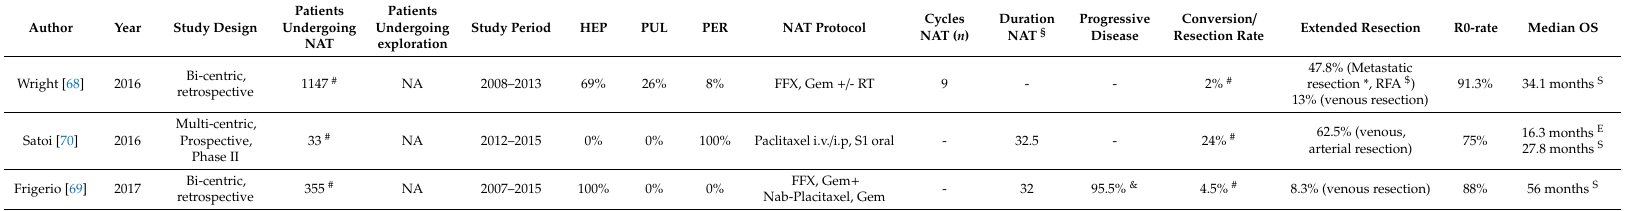
Table 2. Overview of chemotherapy regimens and conversion resection rates for metastatic pancreatic